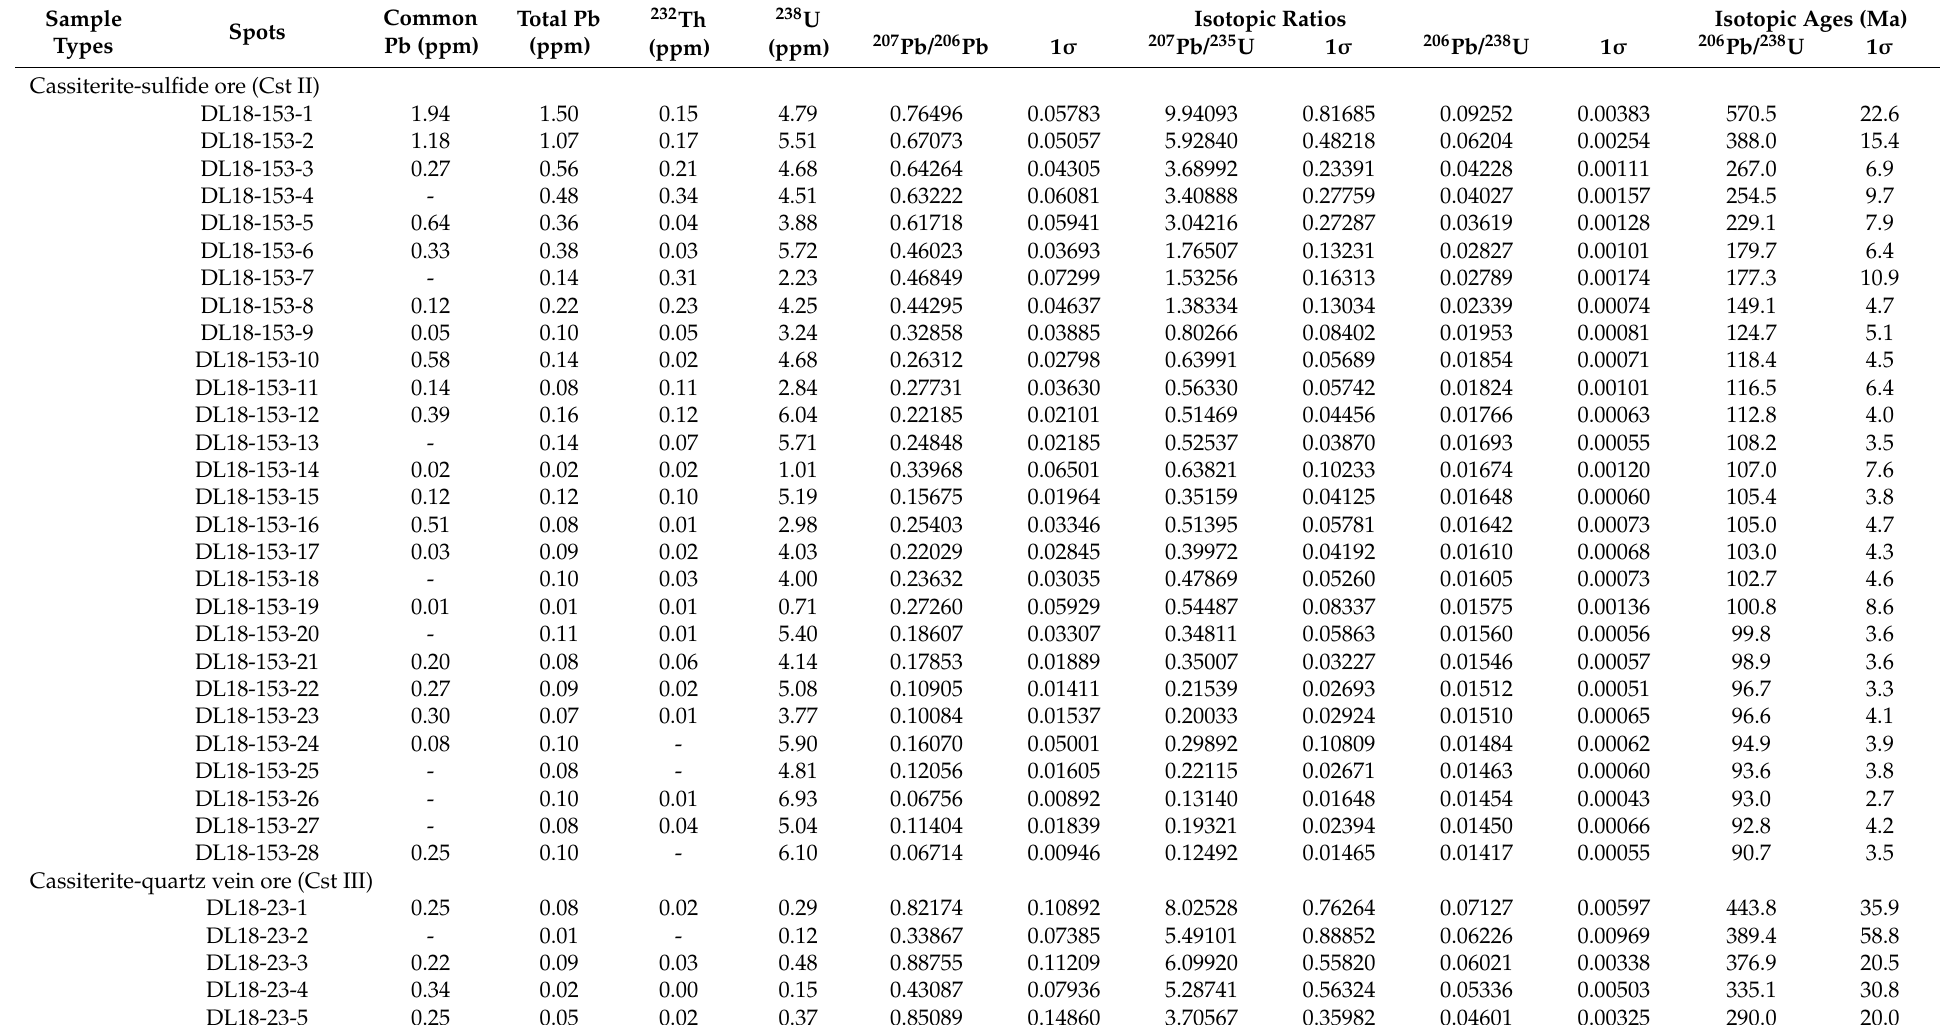
Table 1. LA-ICP-MS U–Pb dating results of cassiterite in the Dulong Sn-Zn-In